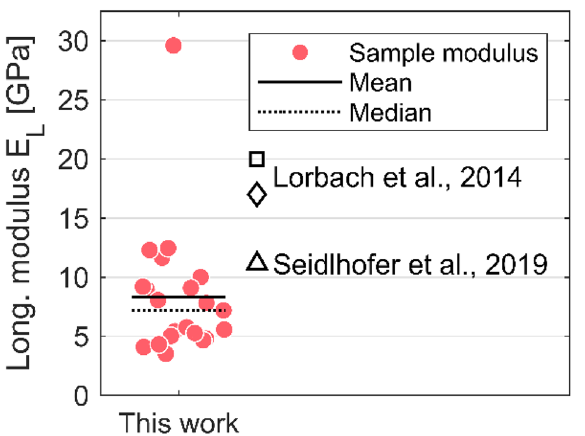
Figure 4. Longitudinal moduli obtained from micromechanical tensile tests in comparison to three mean estimates from previous studies on the same pulp 24,25 . The experimental results are spread on the x-axis to improve visibility.